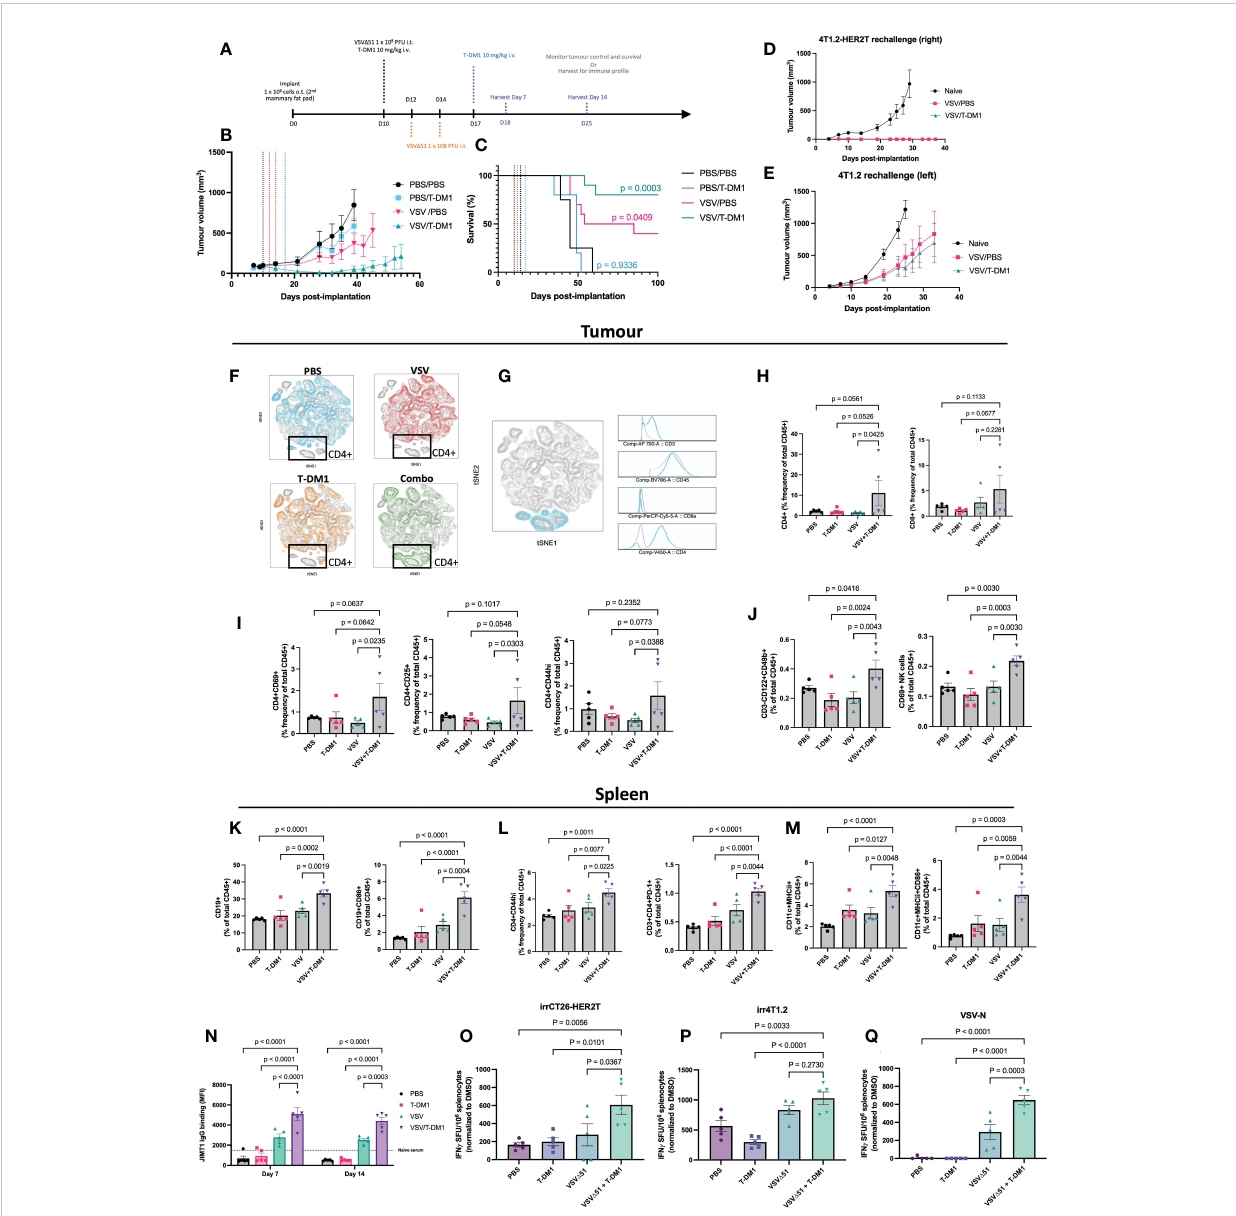
FIGURE 7 Treatment combination of VSV D 51 + T-DM1 leads to humoral anti-tumour response and immunologic memory. (A) Implantation of 4T1.2-HER2T o.t. tumours and treatment regimen timeline (B, C) BALB/c mice were implanted with 4T1.2-HER2T o.t. tumours and treated as indicated (n=5 per group). Tumour volumes (B) and survival (C) were monitored. Survival data p-values relative to PBS control. (D, E) Cured mice from (B, C) were rechallenged with (D) 4T1.2-HER2T tumours in the right side or (E) 4T1.2 parental tumours in the left side, of the 3 rd mammary fat pad. (F – M) Following treatment, n=5 mice were harvested per group at day 7 post-treatment. (F) opt-SNE and FIt-SNE algorithms applied to D7 T-cell data. Overlays for each treatment group is indicated. (G) Identi fi cation of CD4+ signature in the highlighted (blue) population using multigraph overlays. (H) Tumour-in fi ltration total CD4+ and CD8+ T-cell populations (I) tumour-in fi ltrating activated CD4+ T-cells (CD69, CD25, CD44hi), (J) Tumour total and activated CD69+ NK cells, (K) Splenic total and activated CD86+ B-cell, (L) Splenic activated CD4+ T-cells (CD44hi or PD-1+), (M) Splenic total and activated CD86+ dendritic cells, (N) Serum was collected from mice at D7 and D14, and assessed for HER2-reactive IgG. (For all bar charts: mean ± SEM, n=5 per group; p-value calculated by one-way ANOVA, or two-way ANOVA for (L) , with Fisher ’ s LSD test). Representative contour plots shown in Figure S5. (O – Q) IFN g ELISPOT results from murine splenocytes isolated from the spleens at D14, and stimulated with (O) irradiated CT26-HER2T cells, (P) irradiated 4T1.2 cells, or (Q) VSV-N peptide. (mean ± SEM, n=5 per group; p-value calculated by one-way ANOVA, with Dunnett ’ s correction for multiple